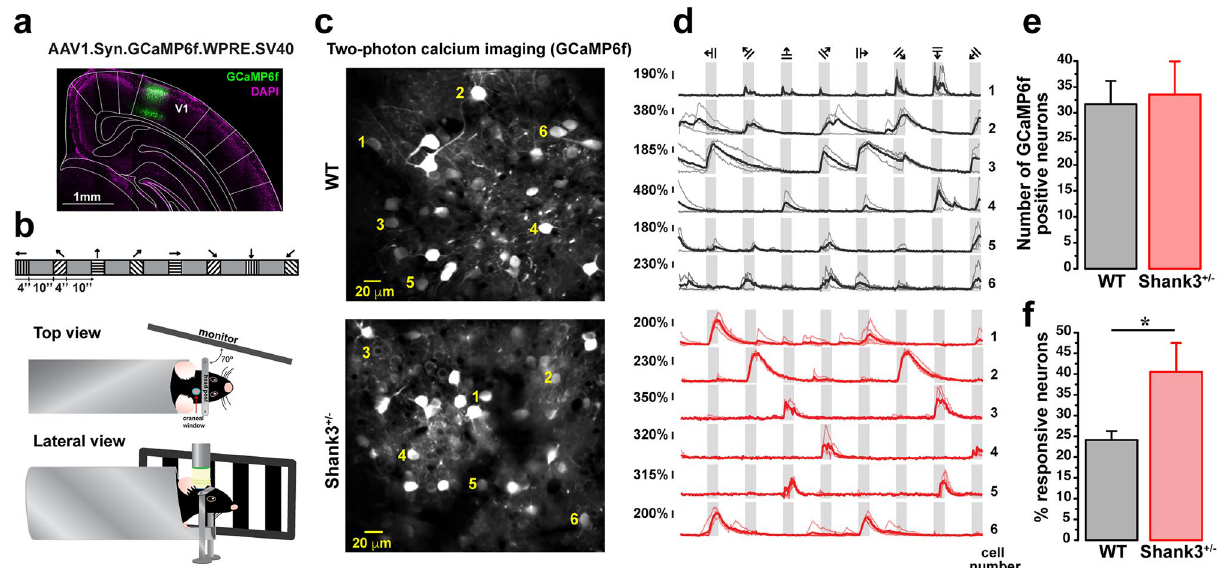
Figure 1. In vivo calcium imaging of L2/3 neurons in V1. ( a ) Representative image of an AAV.Syn.GCaMP6f. WPRE.SV40 injection into V1. ( b ) Cartoon of in vivo two-photon calcium imaging in V1 from head-fixed awake mouse and visual stimuli. ( c ) Representative field of view showing GCaMP6f positive neurons from WT and Shank3 +/− mice. Numbers represent examples of somas. Imaging was performed 3–4 weeks after AAV injection, acquired at 5 Hz. ( d ) Calcium transients (∆F/F 0 ) of the neurons labeled in ( c ), individual traces (lighter lines), and mean traces (dark lines) are shown from WT (black traces) and Shank3 +/− (red traces) mice. Gray background bars indicate the visual stimuli (4 s). ( e ) Quantifying GCaMP6f positive neurons for both genotypes (Student´s t -test, p = 0.811). Bars represent means ± SEM. ( f ) Percentage of responsive neurons from individual regions of interest in WT and Shank3 +/− mice (Student’s t -test, * p = 0.018). Bars represent means ±